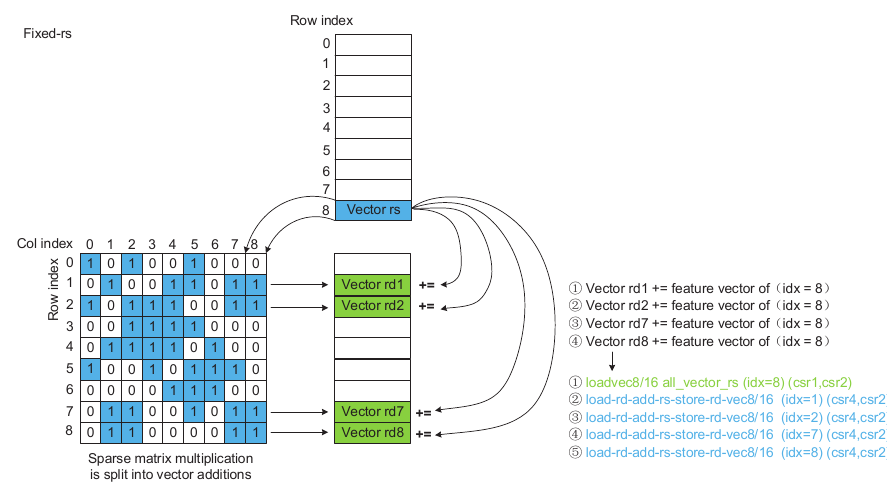
Figure 14. The computation process of fixed-rs